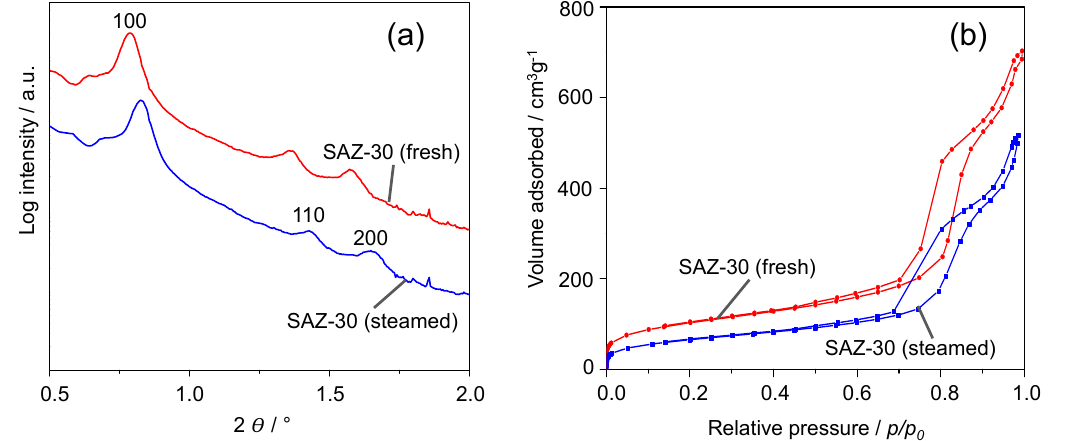
Figure 4. Effect of steaming on the structural and textural properties of SAZ-30: ( a ) SAXS patterns, ( b ) N sorption 2